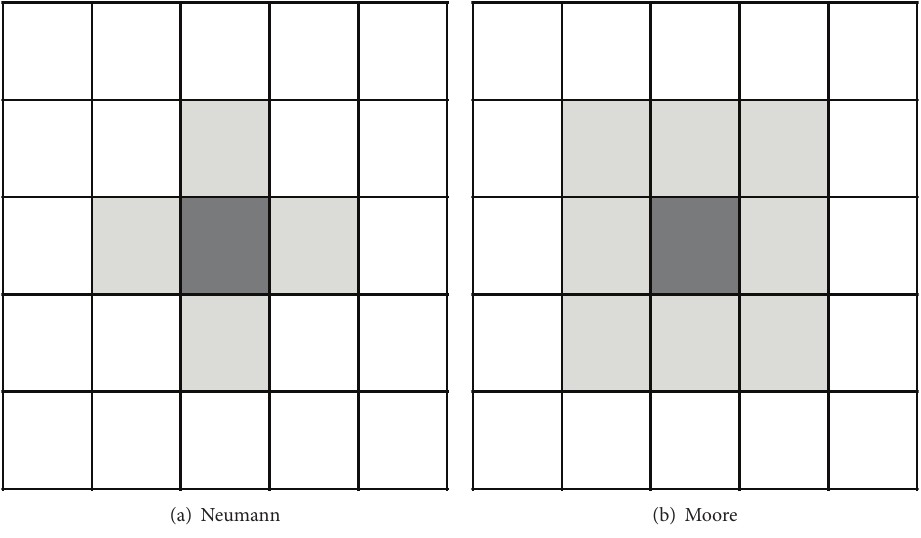
Figure 1: Neighboring